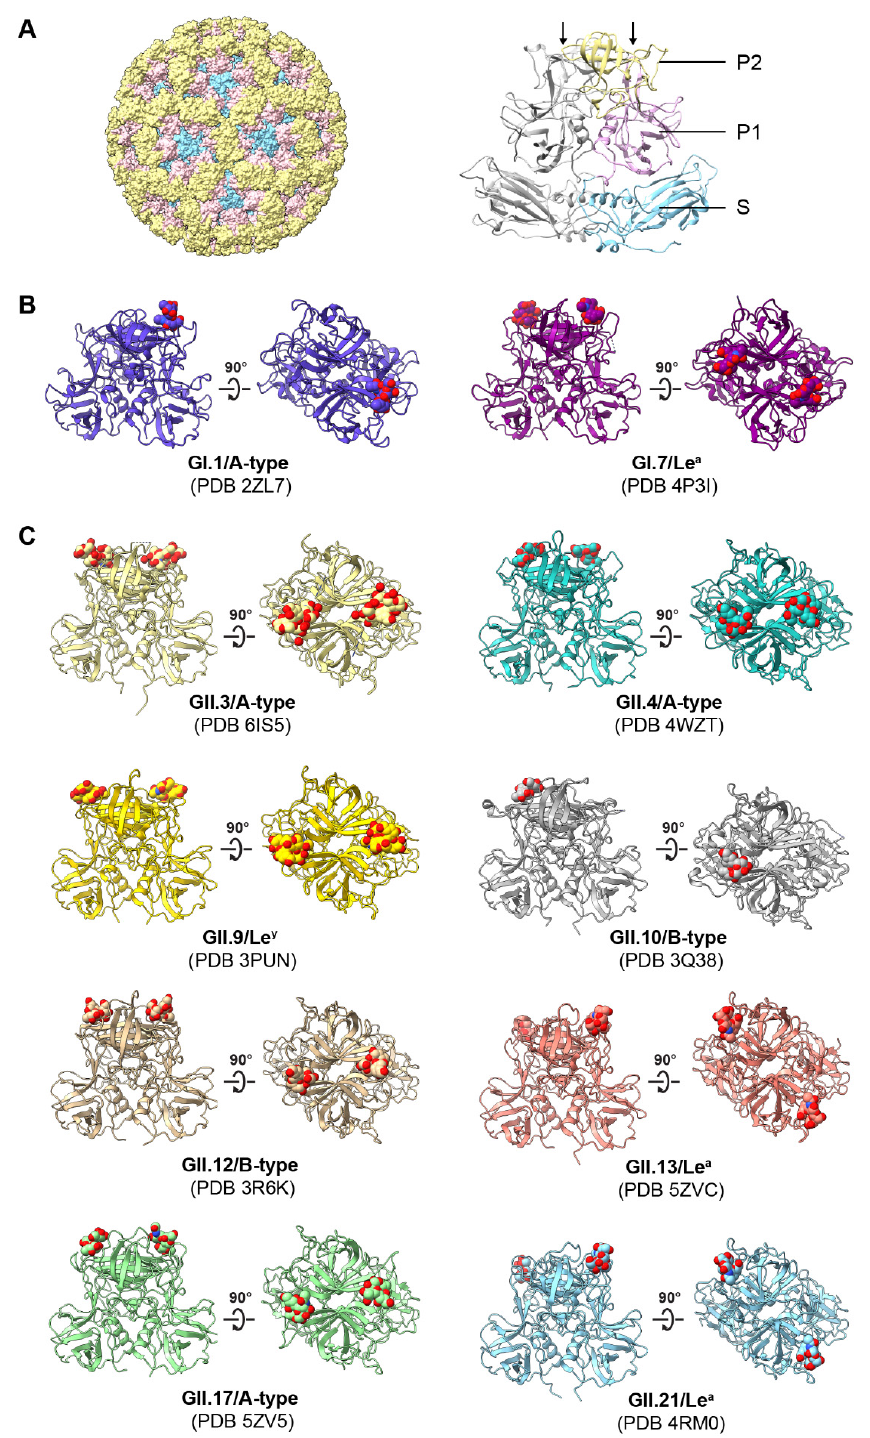
Figure 2. HBGAs bind to HuNoV P domain. ( A ) Crystal structure of the Norwalk virus-like particle (left) comprised of 90 VP1 dimers (right) (PDB ID: 1IHM). The S domain, P1, and P2 subdomains are colored in blue, pink, and yellow, respectively. The second chain of the VP1 dimer is shown in gray. Arrows point to the P-loops in P2. ( B , C ) HBGA binding sites located on P domain dimers of GI and GII HuNoVs. The P domains (ribbon representation) and HBGAs (spheres) are shown as side views of the P domain dimers or rotated 90 degrees to show a top view. HBGA carbon coloration matches the ribbon diagram and heteroatoms are colored by element: oxygen, red; nitrogen, blue.